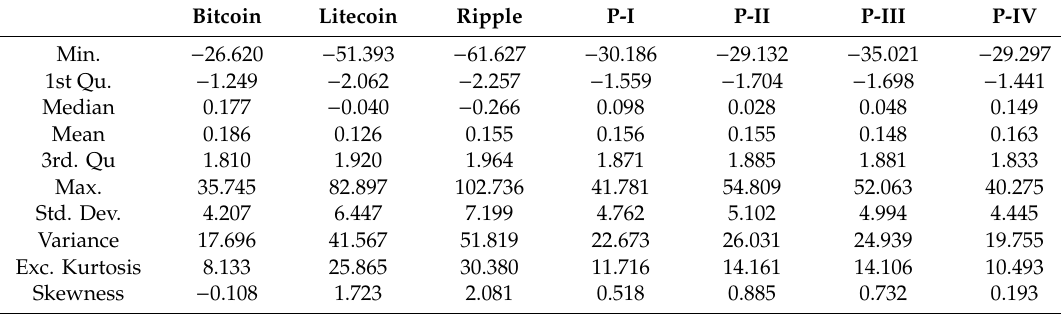
Table 1. Descriptive Statistics for Cryptocurrency Returns.